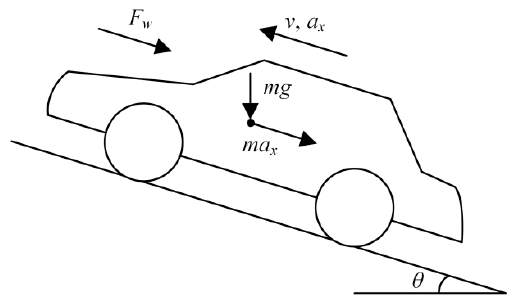
Figure 1. Vehicle longitudinal dynamics model.